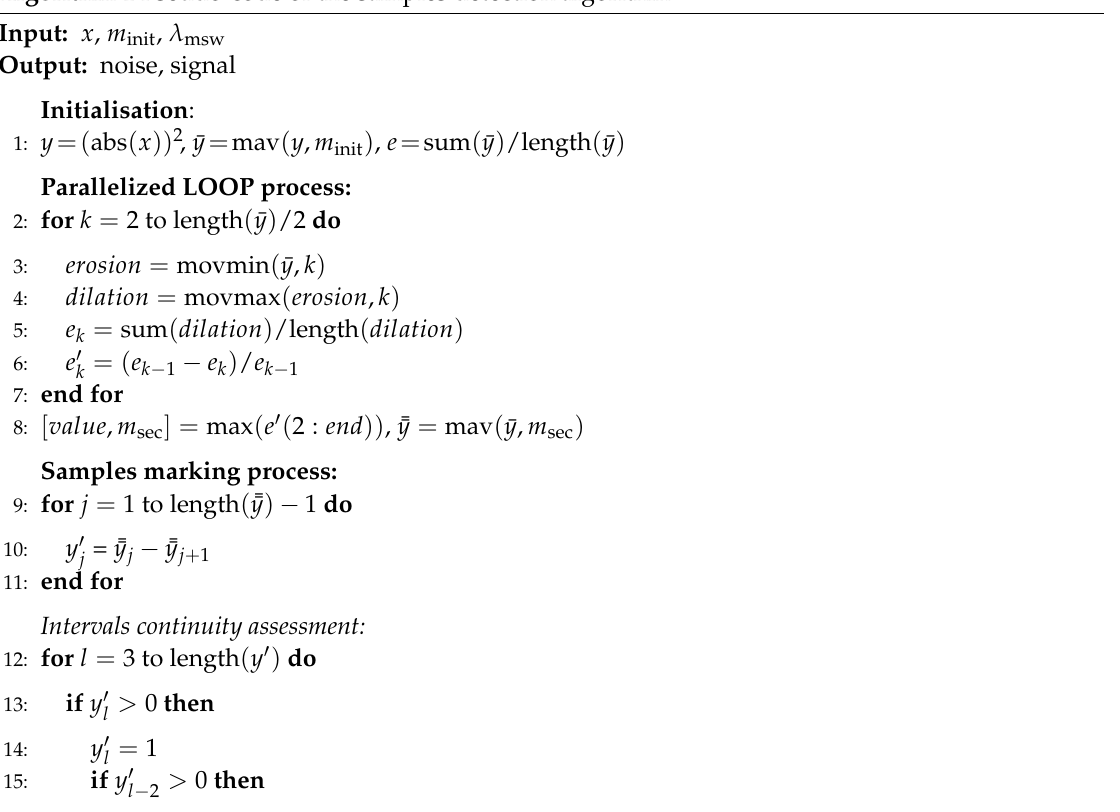
Algorithm 1 Pseudo-code of the samples detection